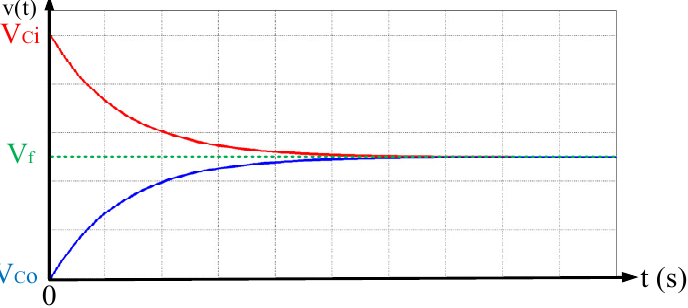
Figure 22. Waveforms representing the discharge of one capacitor into another capacitor in full charge mode.